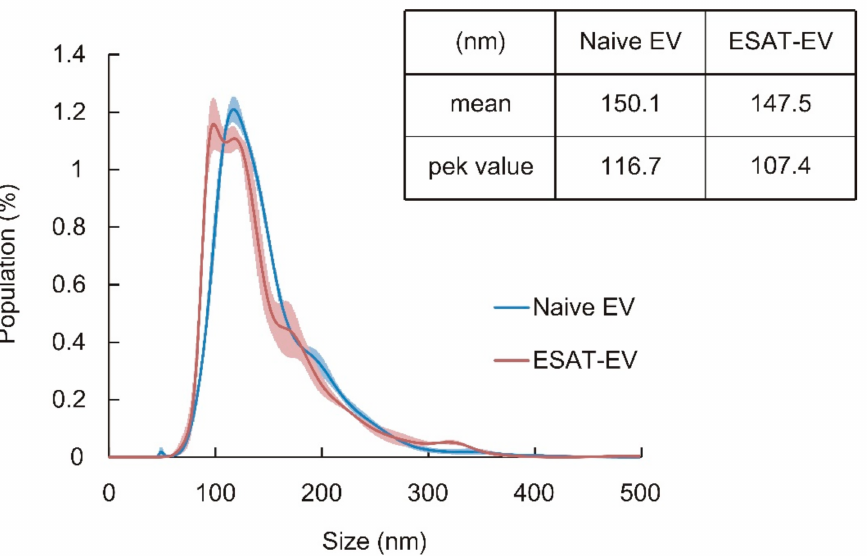
Figure 4. Particle size distribution, mean size, and peak value of EVs. EVs isolated from the culture medium of the B16 cells transfected by DNA/PEI/CS ternary complex (ESAT-EV) and those from the non-treated cells (Naive EV) were analyzed for their size and size distribution with NanoSight LM10. Blue and red lines denote the size distribution profiles of Naive EV and ESAT-EV,